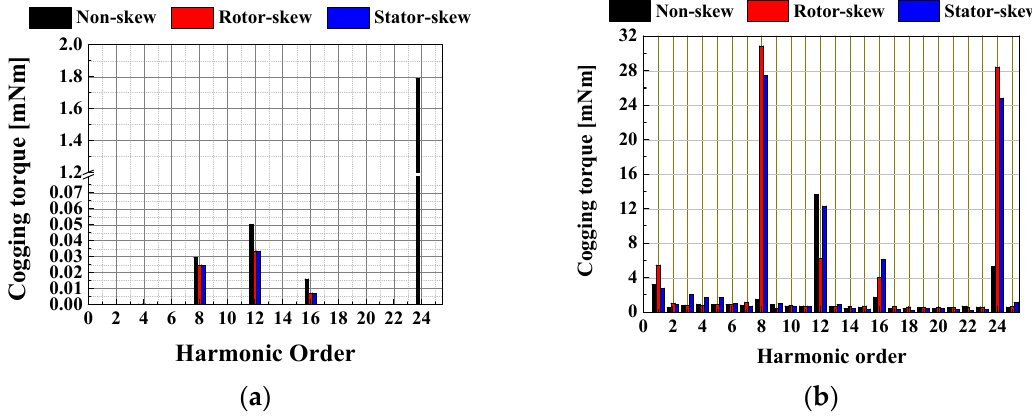
Figure 4. Harmonic order of the cogging torque for the results of FEA and measurement: ( a ) harmonic order of cogging torque for the FEA; ( b ) harmonic order of the cogging torque for the measurement.